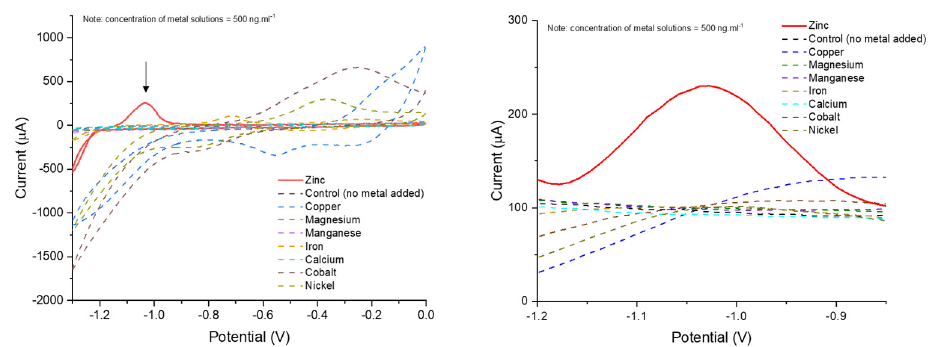
Figure 6. CV in absence and presence of 0.5 mg·mL − 1 of bivalent metals in 0.1 M Tris–HCl (pH 7.5) solution. SWV showing the increase of current after grafting of zincon on CNT in Tris–HCl solution containing concentration of Zn +2 and other metals at a concentration of 0.5 mg·mL − 1 .